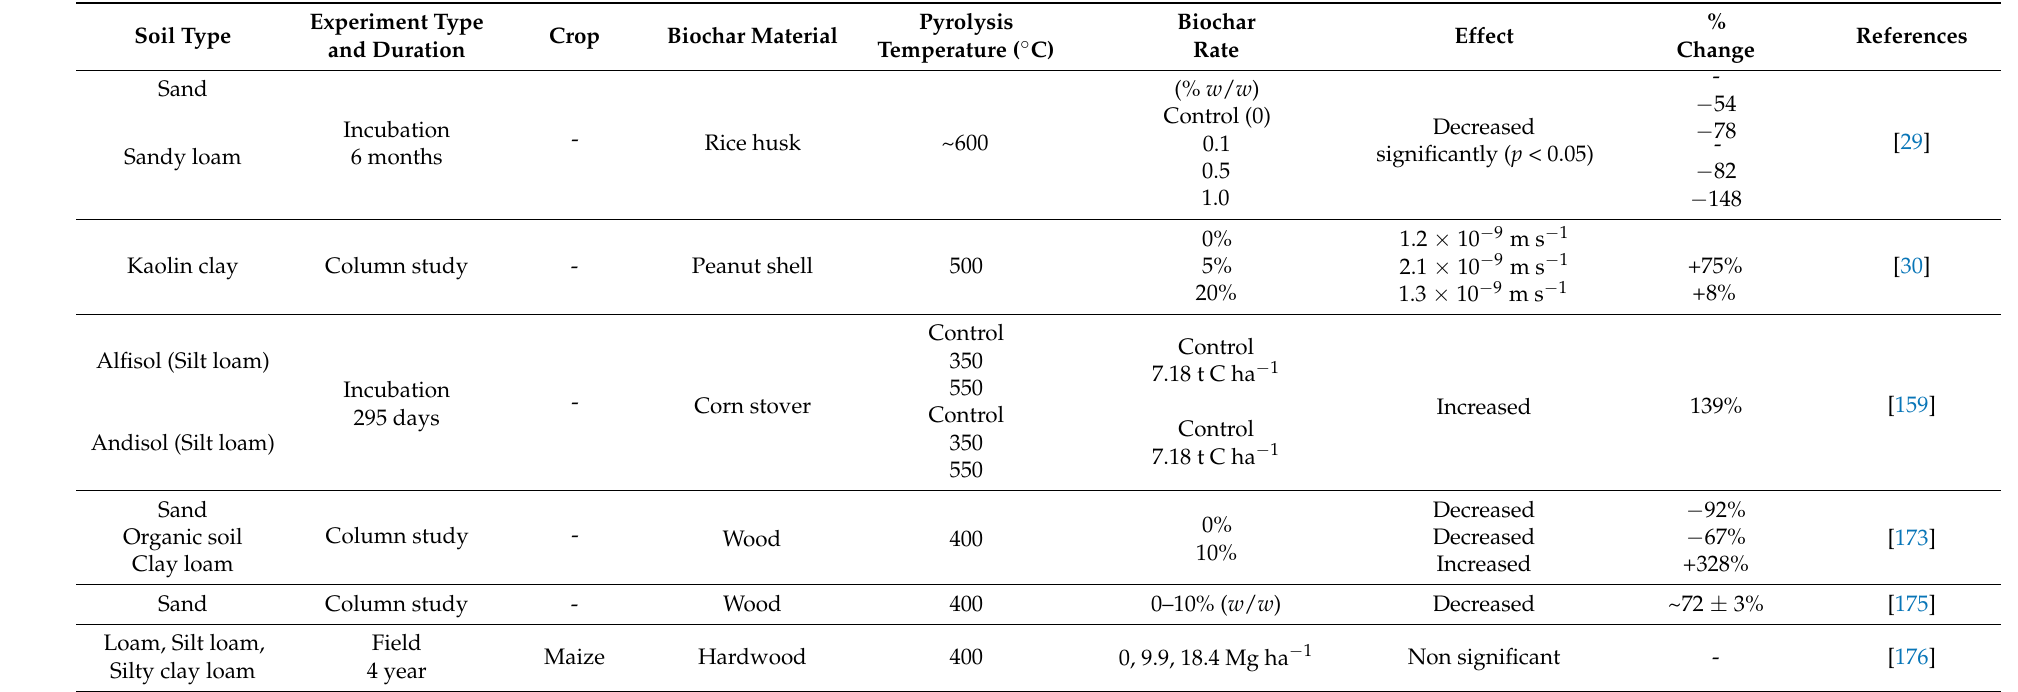
Table 10. Impact of biochar on saturated hydraulic conductivity of different types of